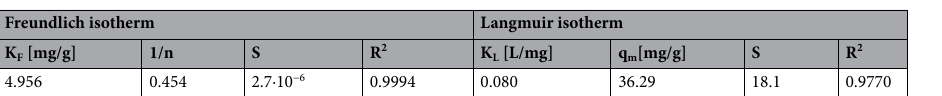
Freundlich isotherm Langmuir